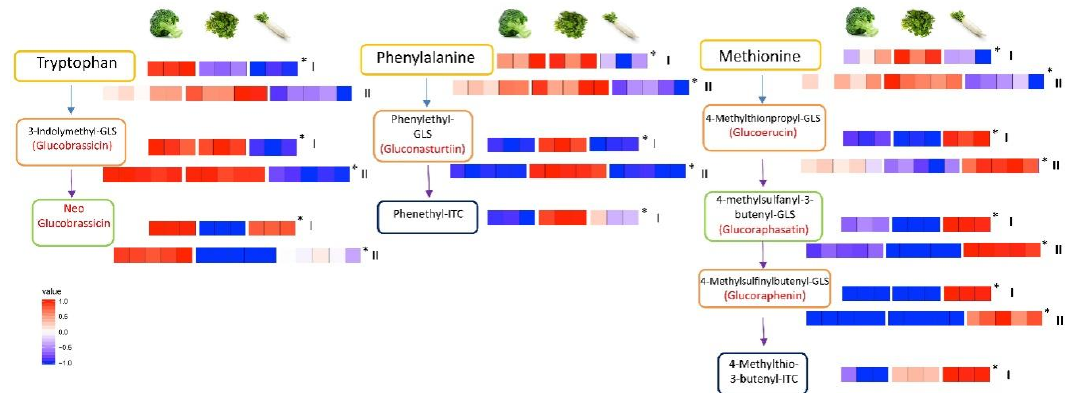
Figure 4. Representative pathway behavior in three vegetables. A heat map of abundances of metabolites detected involved in the pathways from amino acids to glucosinolates and isothiocyanates in three different vegetables which grow in different environments (aboveground broccoli, damp soil or submerged watercress and belowground radish). The data was collected using an untargeted approach and the presented heat maps depict the discovery set of three samples and validation data consisting of 5 samples. The isothiocyanates could not all be included in the validation dataset. The intensities of metabolites in the heat map were expressed as relative levels in broccoli, radish and watercress. Asterisks denote statistical significance by Student’s t -test ( p < 0.05). ITC: isothiocyanate.